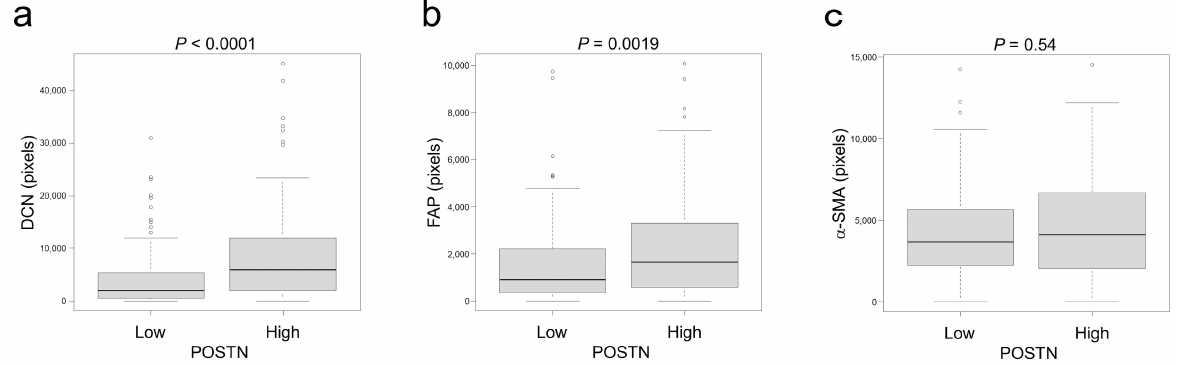
Figure 4. Association between stromal POSTN and CAF marker expression. ( a – c ) Association between POSTN and CAF marker expression. ( a ) DCN, ( b ) FAP, and ( c ) α -SMA. POSTN was significantly associated with DCN and FAP but not α -SMA. The circles indicate